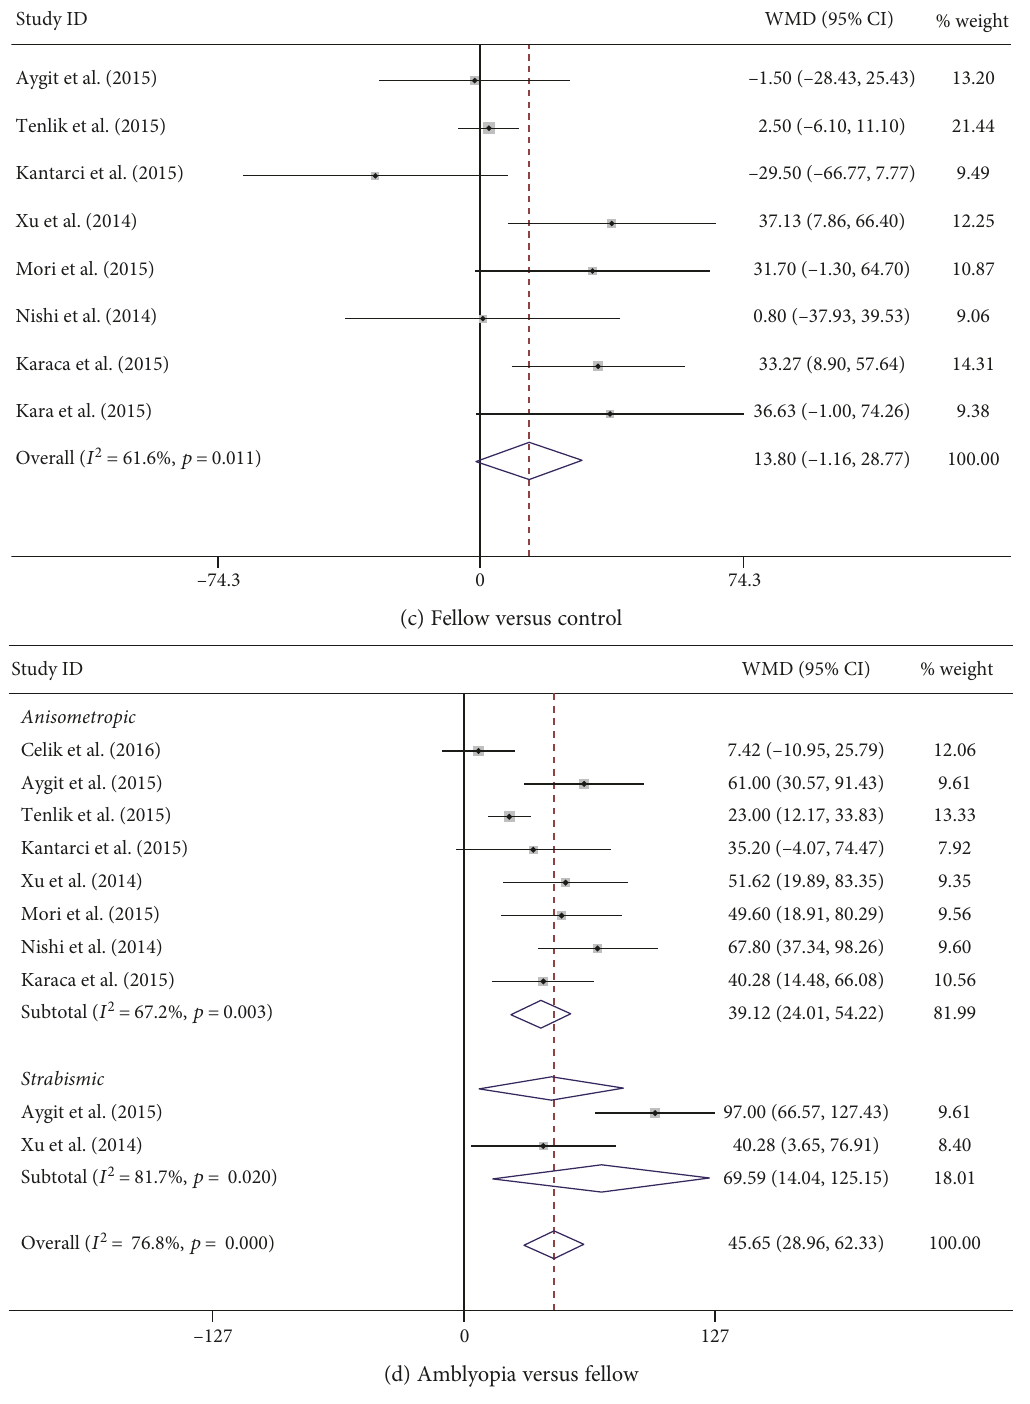
Figure 2: Pooled estimates for all studies comparing SFCT in the amblyopic eye with the fellow eye and the normal control eyes. (a) The amblyopic eye versus the fellow eye. (b) The amblyopic eye versus the control eye. (c) Fellow versus control. (d) Amblyopic type subgroup analysis when the amblyopic eye is compared to the fellow eye. The SFCT of the amblyopic eye was thicker than that of both the fellow and the control eyes, both in the overall and in the subgroups (AL matched/not). The results for the amblyopic type subgroup analysis were the same as for the axial length subgroup analysis. Note: weights are from random e ff ects